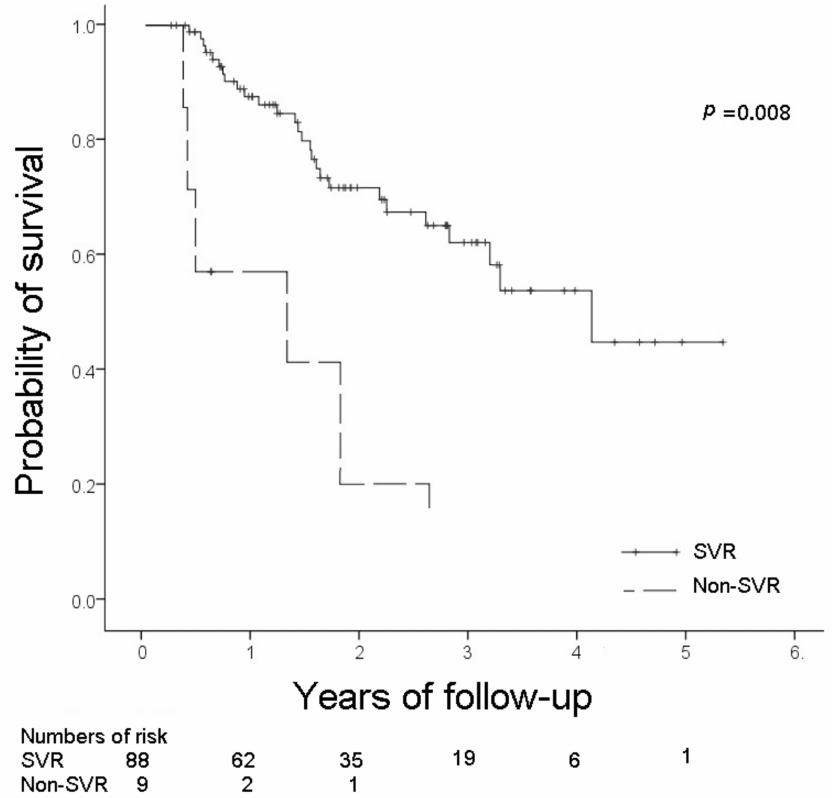
Figure 1. Cumulative probability of survival stratified by SVR and non-SVR (SVR, sustained viral